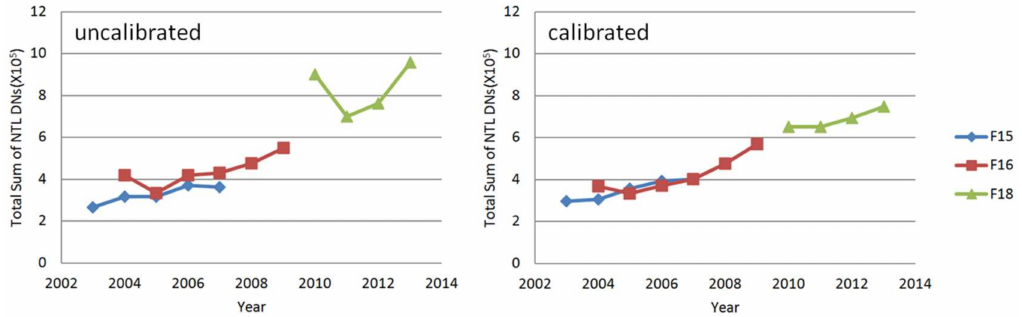
Figure 6. Total sum of NTL in the uncalibrated and calibrated DMSP-OLS images in the study